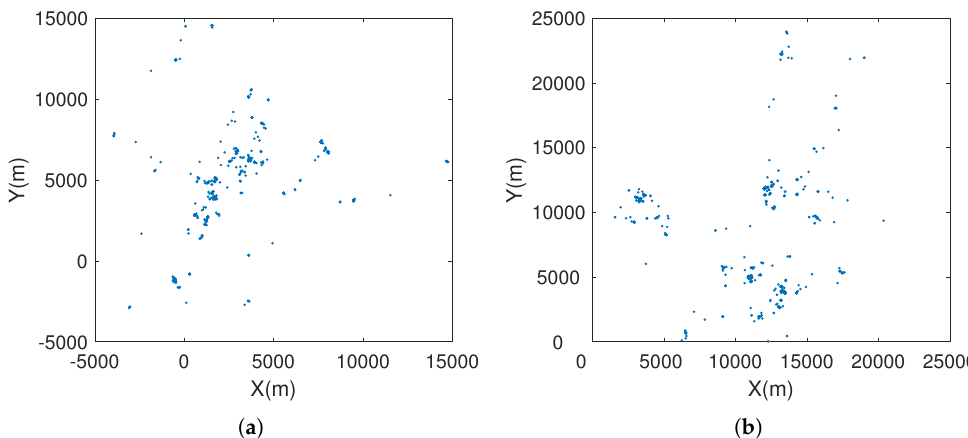
Figure 3. The dispersions of spots on the map. ( a ) New York City real map. ( b ) The synthetic map generated by